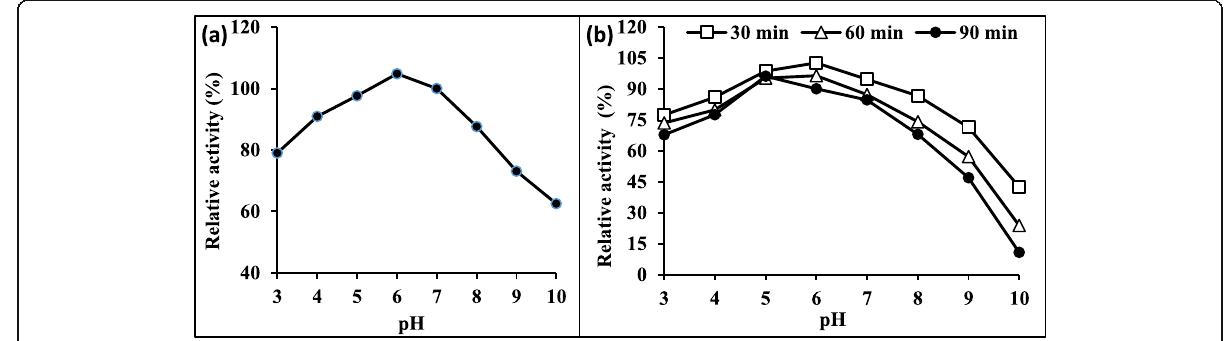
Fig. 3 Effect of pH ( a ) and stability ( b ) on the activity of partially purified lipase produced by R. oryzae R1. Initial activity (100%) = 195.6U/mL at